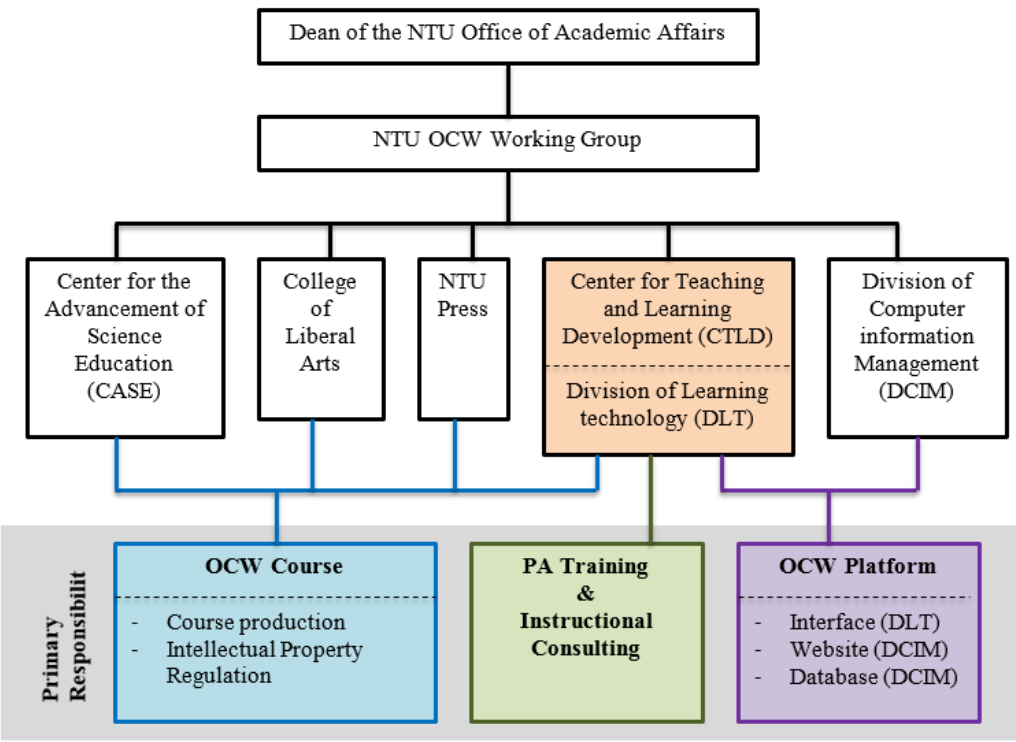
Figure 1. Organization structure and primary